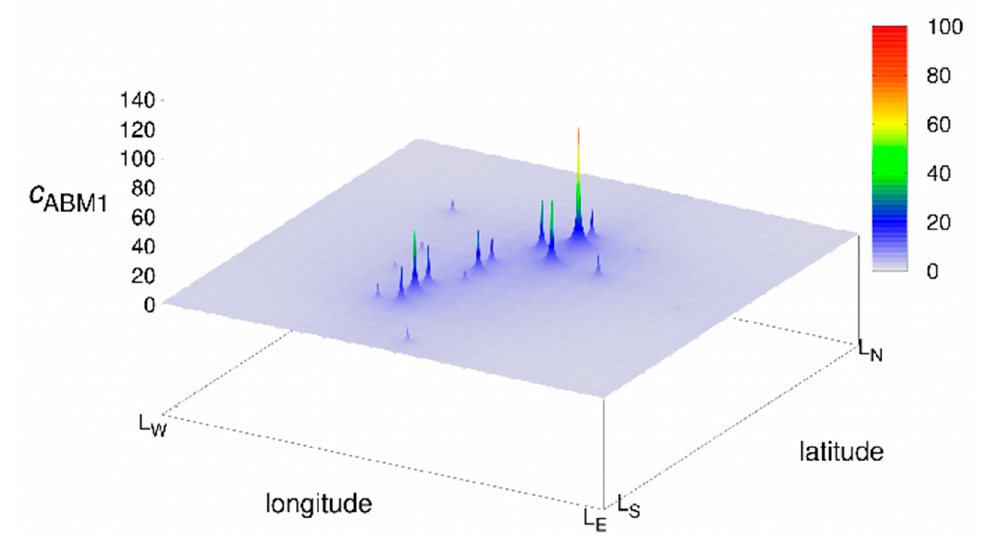
Figure 6. Distributions of agent visits based on agent-model simulations. Agents are mobile in network with graph topology shown in Figure 4. We removed two nodes since the counts at these two points have more values than the others: node 11 (counts = 50) and node 231 (counts = 3554).